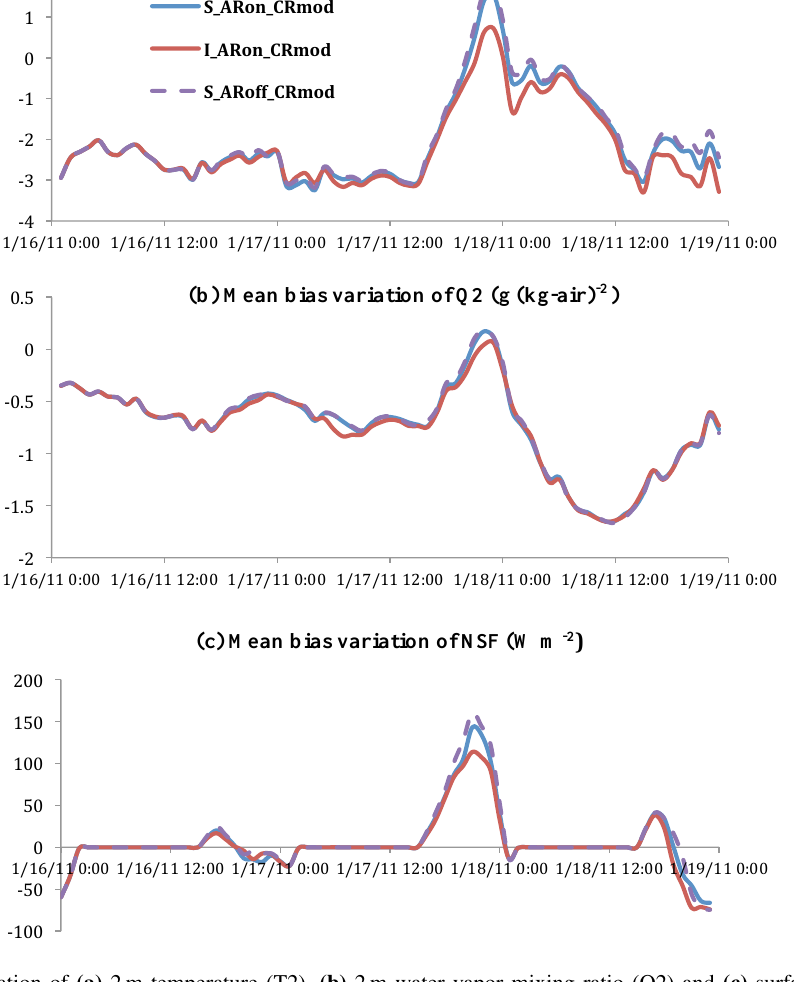
Figure 9. Mean bias variation of (a) 2m temperature (T2), (b) 2m water vapor mixing ratio (Q2) and (c) surface net downward short- wave radiative flux (NSF) between observations and model simulation from 16 to 18 January 2011 for S_ ARon_CRmod (blue lines), S_ARoff_CRmod (purple lines) and I_ ARon_CRmod (red lines) experiments. Table 6. Ratio of AQC number concentration for each bin/source to the total number concentration. The numbers are averaged within the first five model layers during 16 to 18 January